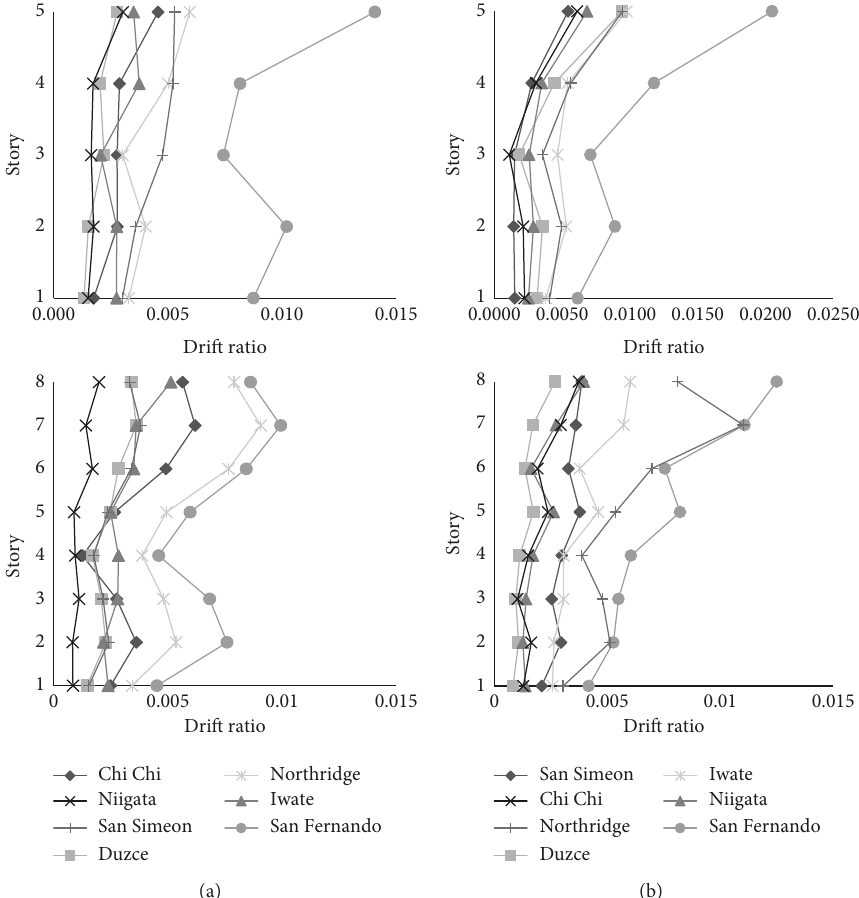
Figure 14: Maximum drift ratio variations of 5- and 8-story frames under far-field records. (a) Soil type II and (b) soil type III. Table 11: Average of maximum drift ratio under far-field records.